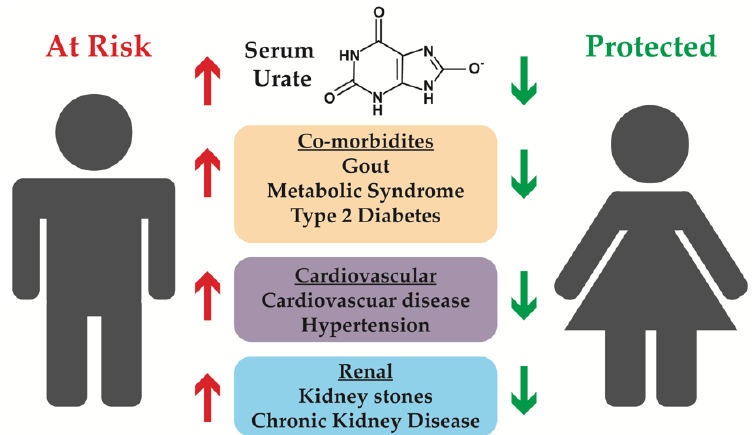
Figure 1. Co-morbidities associated with hyperuricemia, with an emphasis on conditions that can affect the kidneys. Males tend to have higher serum urate levels, and therefore have an increased risk of associated co-morbidities, while females have lower serum urate levels and are protected from developing associated co-morbidities.